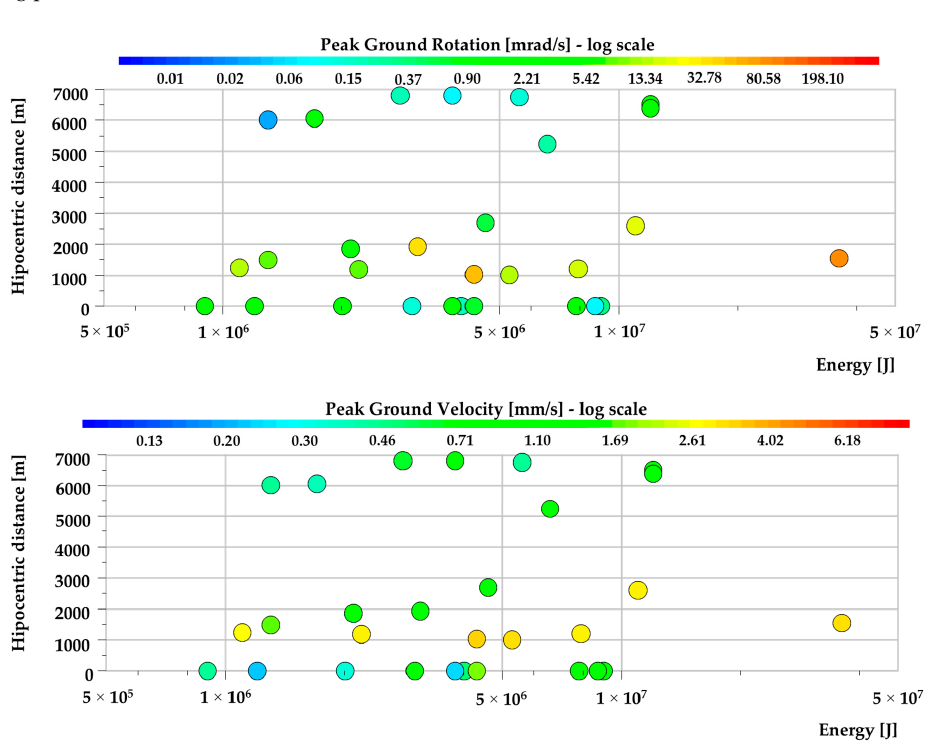
Figure 8. The values of and PG RV ( top ) PG V ( bottom ) recorded near the Rudna-I mining